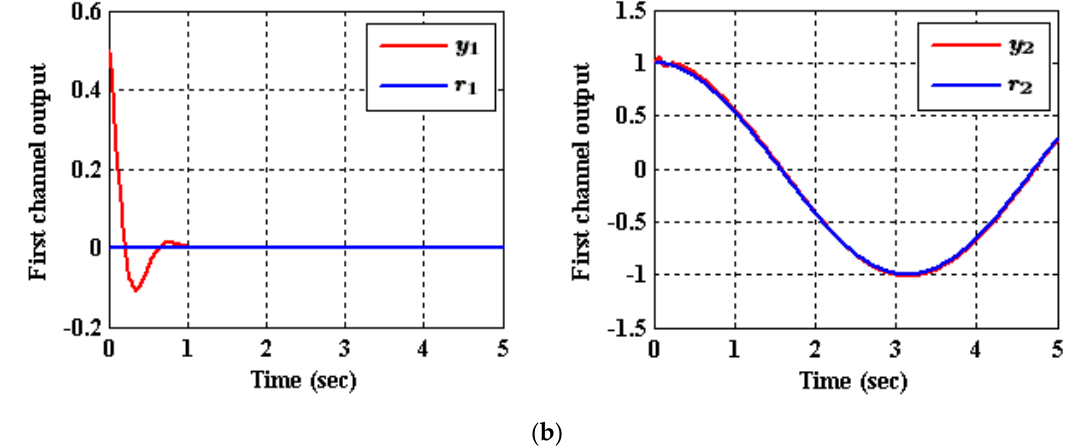
Figure 12. The output tracking of Equation (42) due to reference inputs r 1 and r 2 using decentralized control scheme with CADRC, ( a ) ( r 1 , r 2 ) = ( sin ( t ) ,0 ) , ( b ) ( r 1 , r 2 ) = ( 0,cos ( t )) .